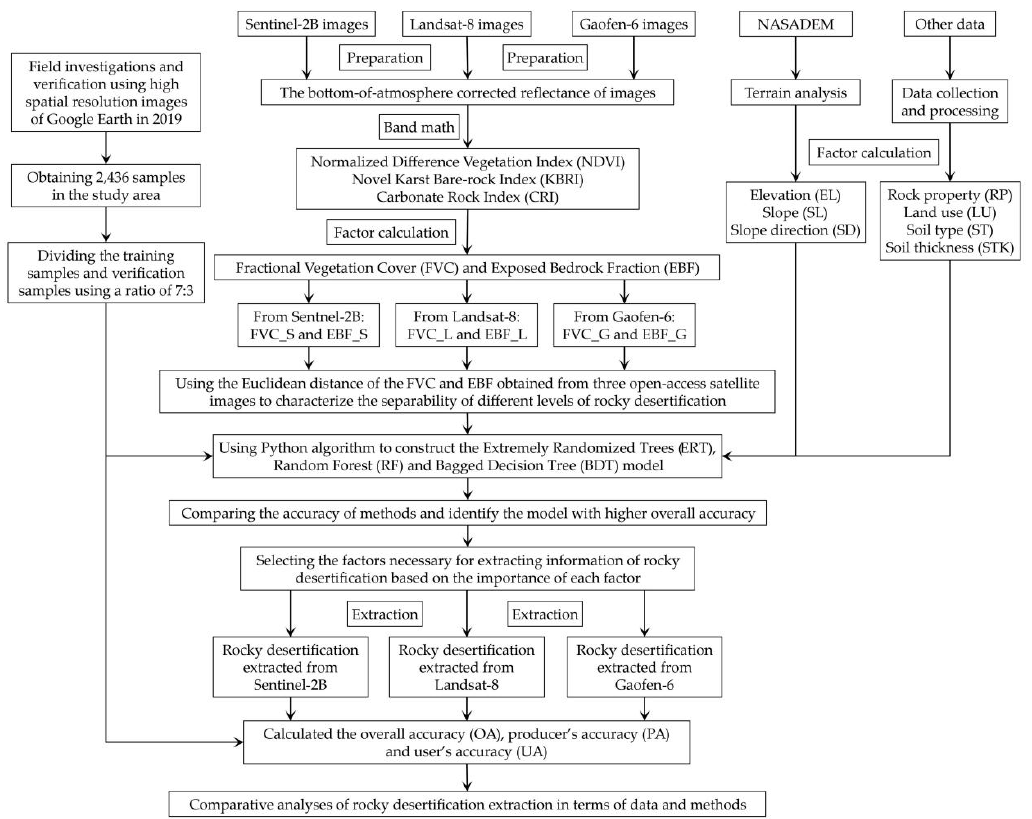
Figure 2. Methodology flowchart of the comparative study.